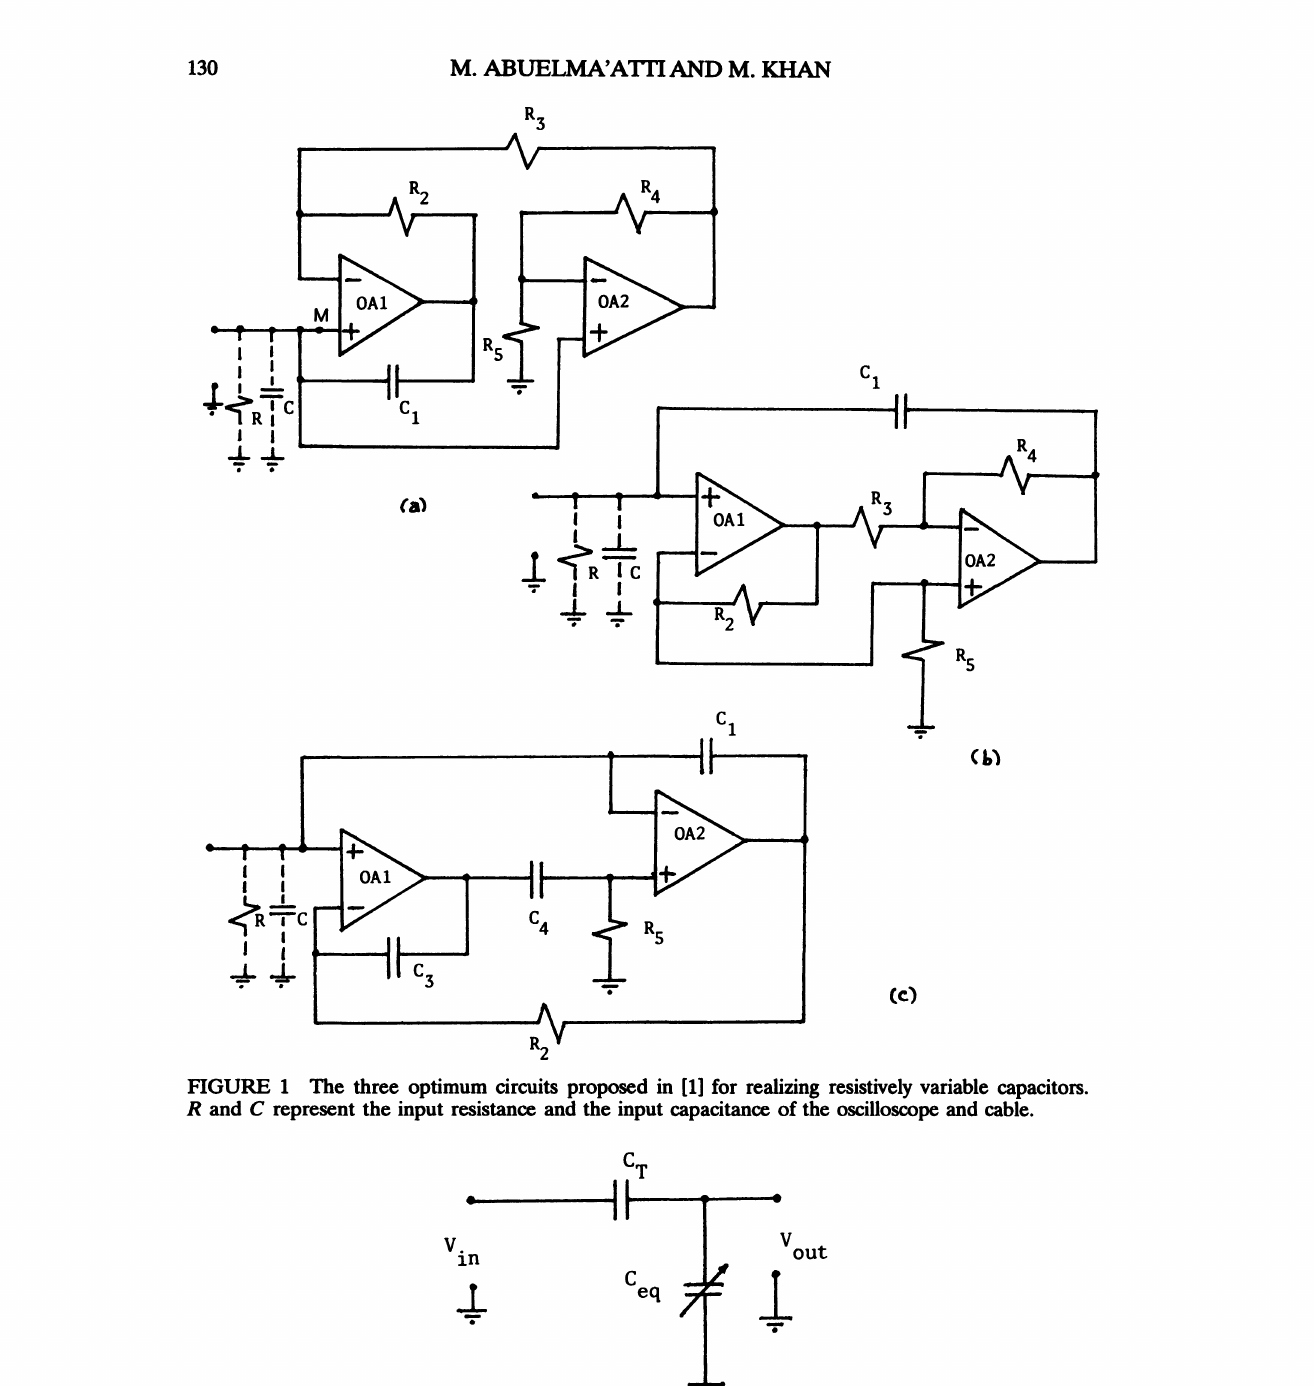
FIGURE 1 The three optimum circuits proposed in [1] for realizing resistively variable capacitors. R and C represent the input resistance and the input capacitance of the oscilloscope and cable.